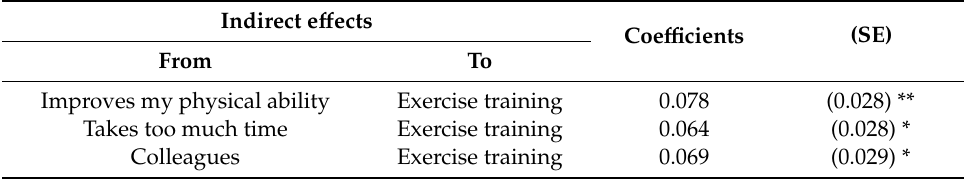
Table 3. Indirect e ff ects of modal salient beliefs on participation in exercise training ( N = 171). Indirect e ff ects Coe ffi cients (SE) From To Improves my physical ability Exercise training Takes too much time Exercise training Exercise